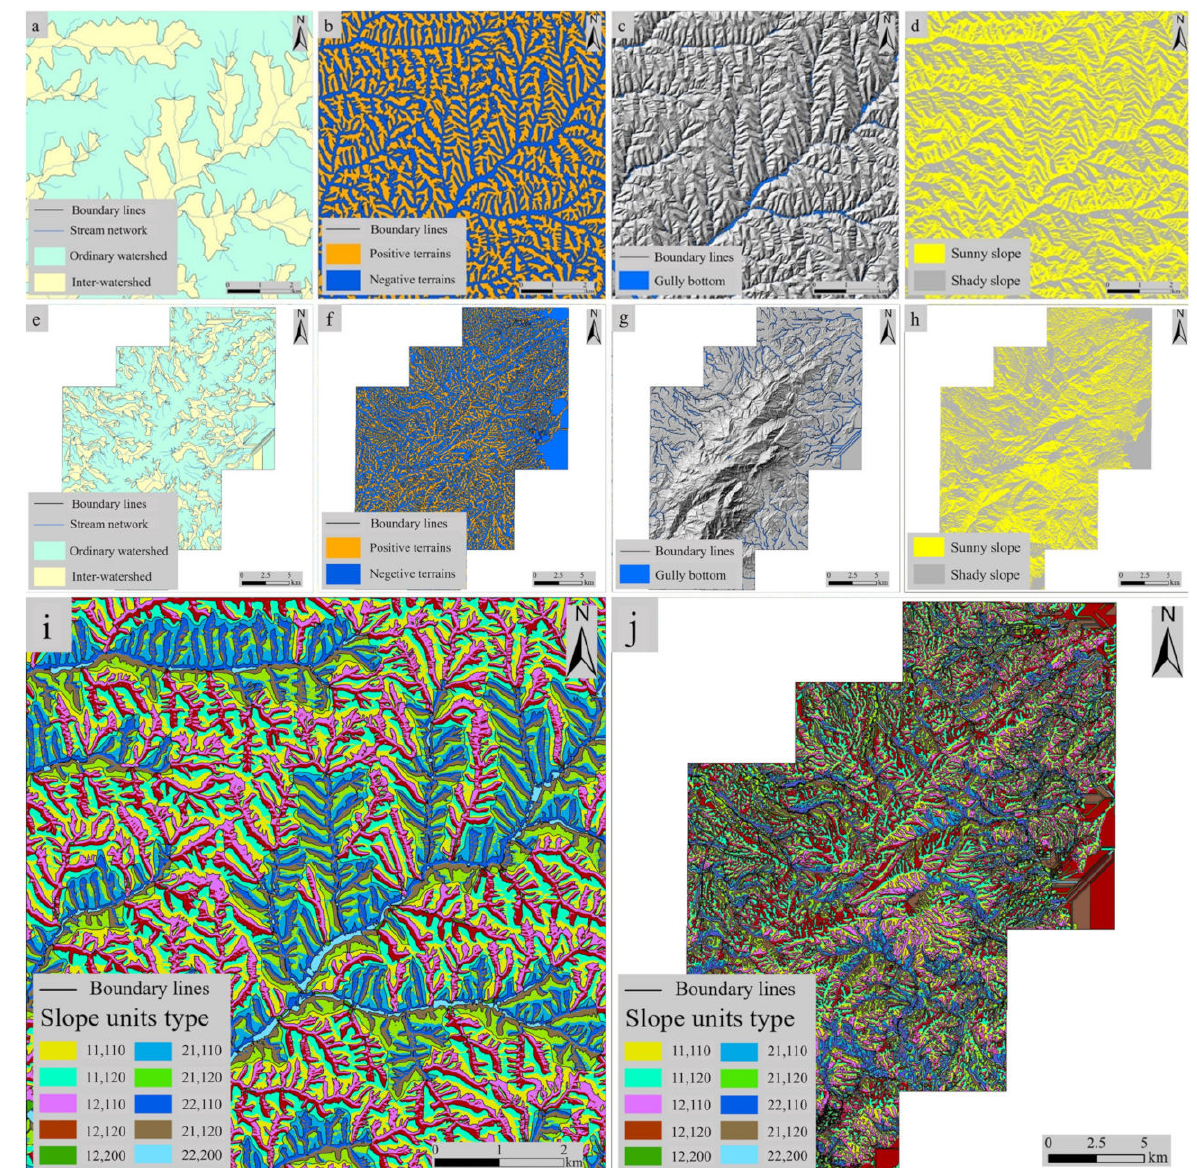
Figure 11. CTFL method process and results: ( a ) ordinary watershed and inter-watershed in Jiuyuan- gou, ( b ) positive terrains and negative terrains in Jiuyuangou, ( c ) non-gully bottom and gully bottom in Jiuyuangou, ( d ) positive terrains and negative terrains in Jiuyuangou, ( e ) ordinary watershed and inter-watershed in Lushan, ( f ) positive terrains and negative terrains in Lushan, ( g ) non-gully bottom and gully bottom division in Lushan, ( h ) positive terrains and negative terrains in Lushan, ( i ) the result of the CTFL method in Jiuyuangou, ( j ) the result of the CTFL method in